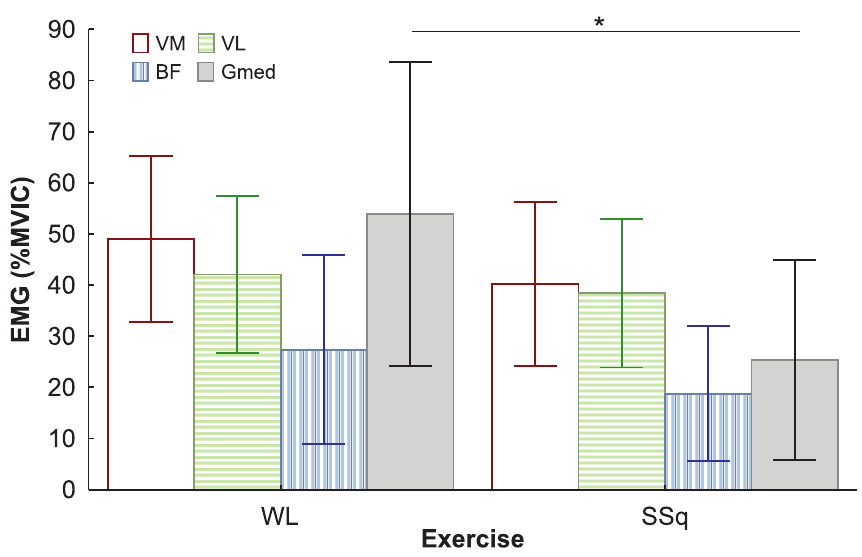
Figure 1. Analysis of variance: differences between exercises. VM = vastus medialis, VL = vastus lateralis, BF = biceps femoris, Gmed = gluteus medius, MVIC = maximal voluntary isometric contraction, WL = walking lunge, SSq = split squat, *significant difference between exercises. Rectangular bars represent means, error bars represent standard